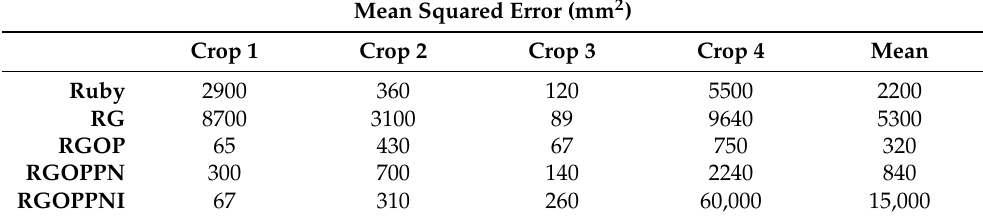
Table 3. The positioning error that the robot made when moving between two crop rows. In a perfect situation, the robot should be exactly in the middle of the two crop rows, and thus should have an error of 0.